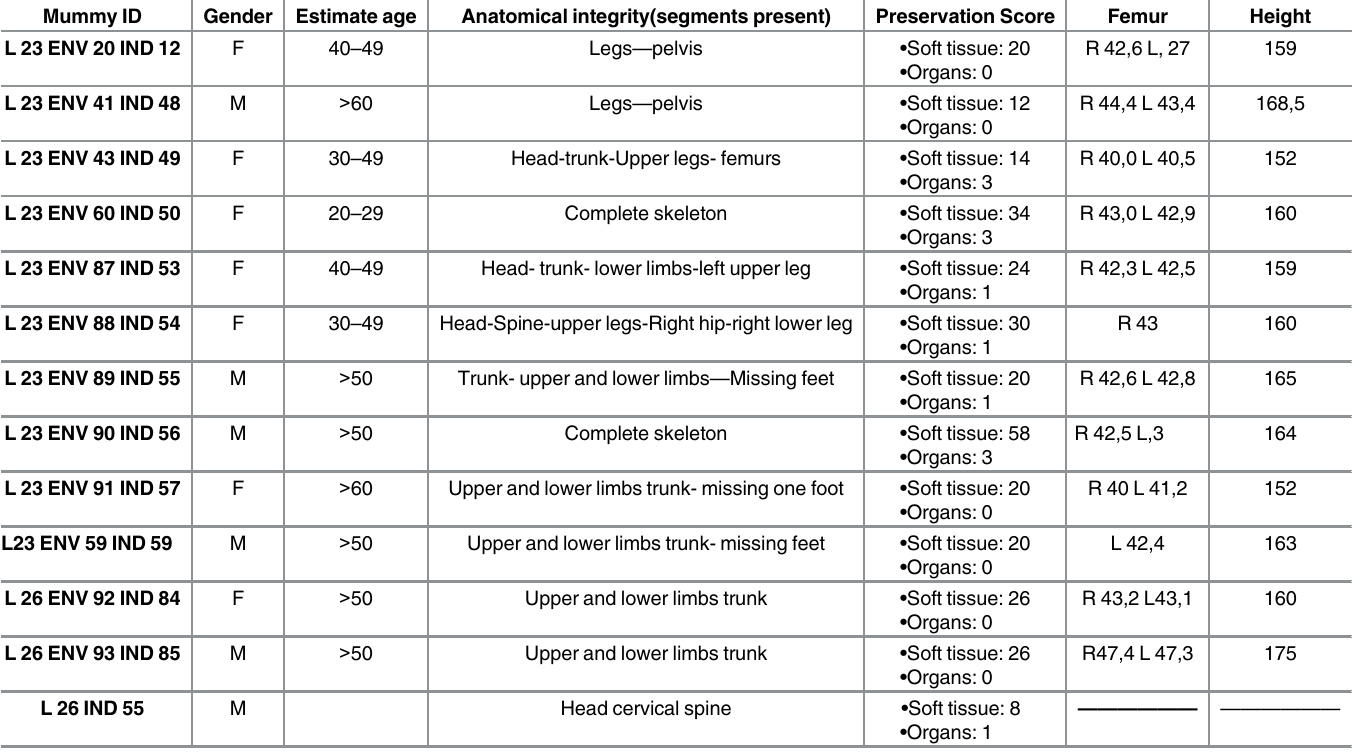
Table 1. General features of the sample with estimated age, gender, anatomical integrity.